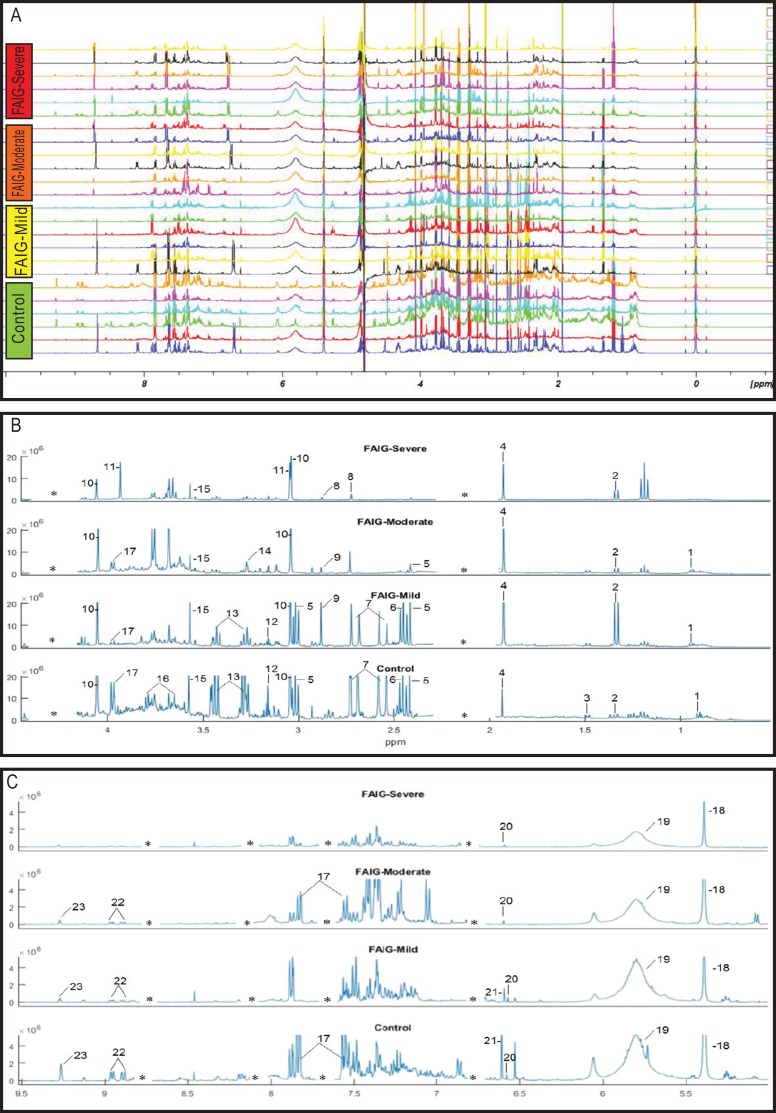
1H-NMR spectra of rat urine from the different experimental groups.(A) 1H-NMR spectra of urine samples of each experimental group. (B) High field of the 1H-NMR spectra of urine samples of each experimental group. (C) Low field of the 1H-NMR spectra of urine samples of each experimental group. Identified metabolites: (1) valine, (2) lactate, (3) alanine, (4) acetate, (5) succinate, (6) oxoglutarate, (7) citrate, (8) dimethylamine, (9) trimethylamine, (10) creatinine, (11) creatine, (12) malonate, (13) taurine, (14) TMAO, (15) glycine, (16) phenylacetylglycine, (17) hippurate, (18) allantoin, (19) urea, (20) aconitate, (21) kynurenate, (22) n-1-methylnicotinamide (23) trigonelline. (*) Removed peaks correspond to the folic acid signals.